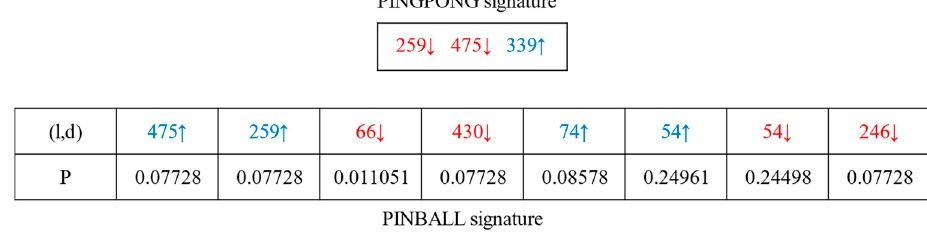
Figure 2. Wemo-plug on-signature.